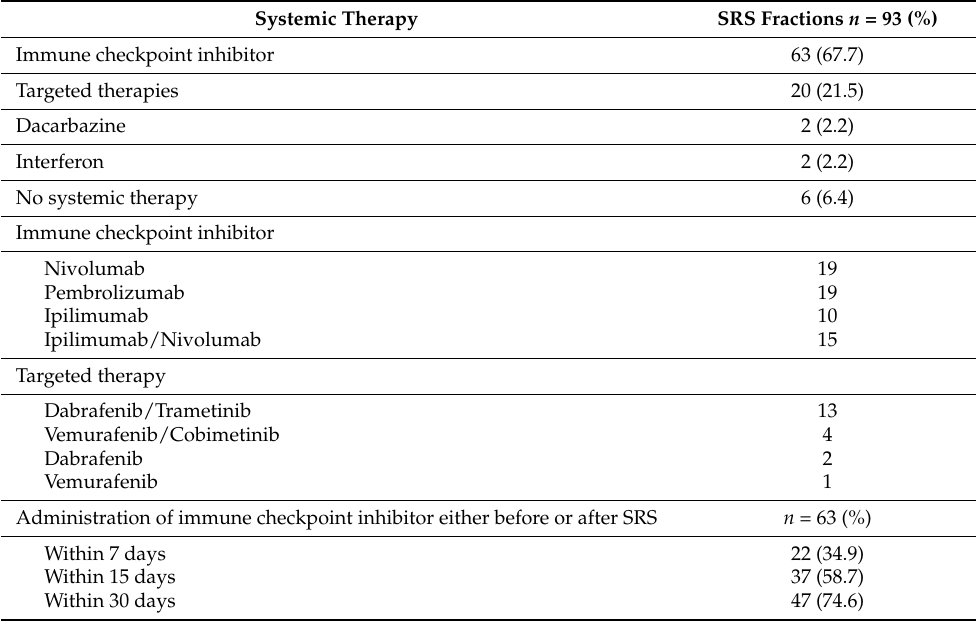
Table 3. Characteristics of the systemic therapy administered timely closest to every SRS